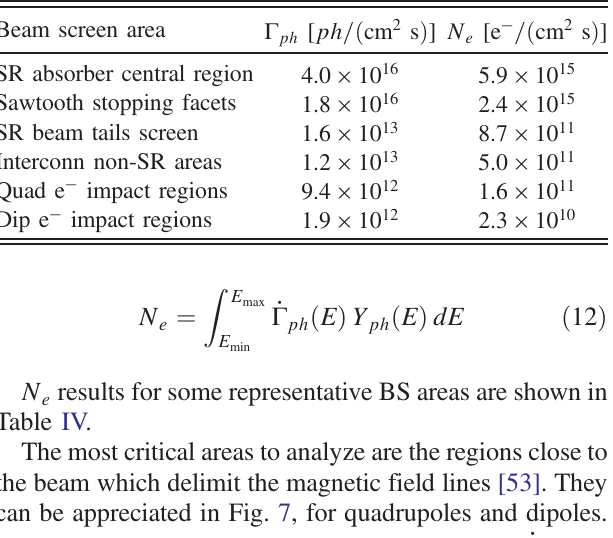
_ Γ TABLE IV. Worst case of (calculated using pessimistic ph sawtooth reflectivity properties) above 4 eV and subsequent N e on different BS regions. 50 TeV, 500 mA beam. Inner chamber e − cloud build-up areas and photon absorber are considered to be treated with LASE. Rest of the showed regions are OFE Cu.